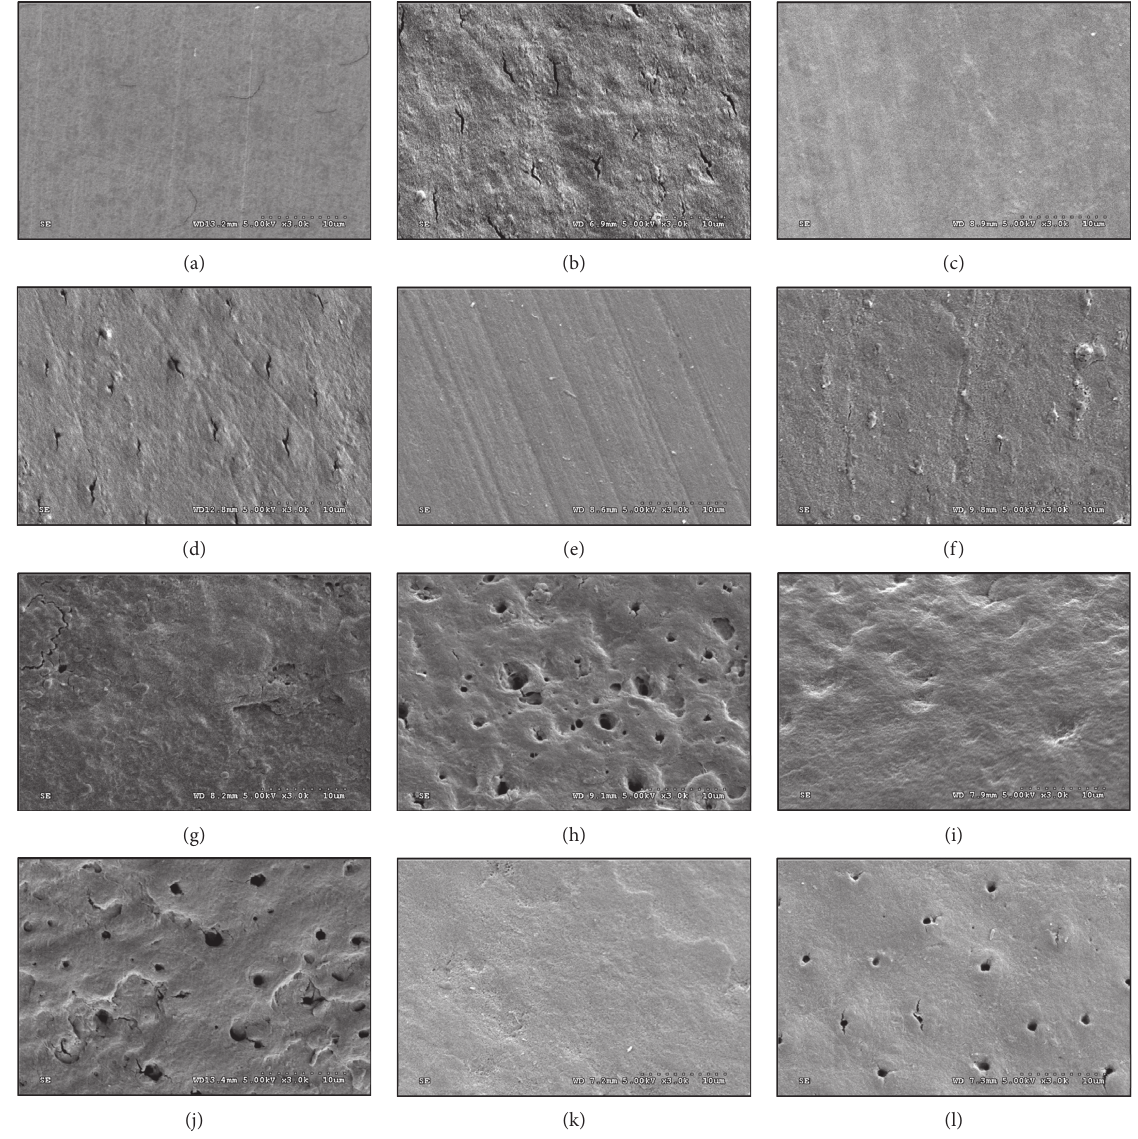
Figure 4: Scanning electron microscopy (SEM) of enamel (a, c, e, g, i, k) and cementum (b, d, f, h, j, l) before material application (a, b), after surface applied with NHA (c, d), and Clinpro (e, f) and after demineralization of nontreated surface (g, h), NHA treated surface (i, j), and Clinpro treated surface (k,